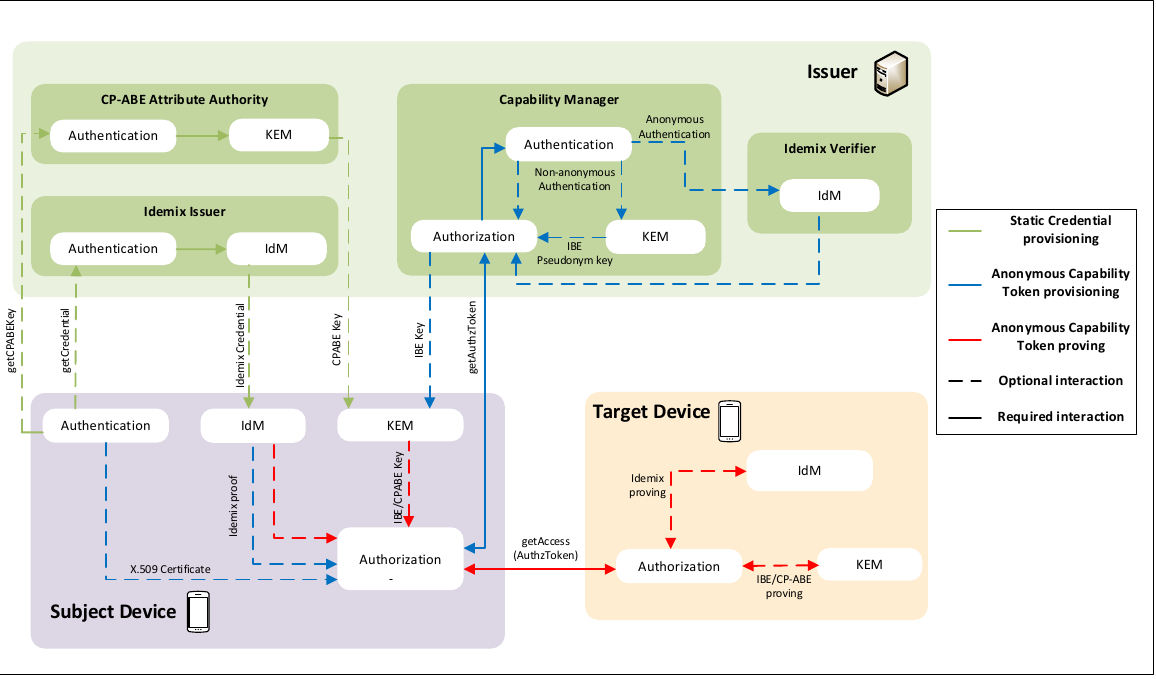
Figure 2. Architecture and framework interactions of the proposed